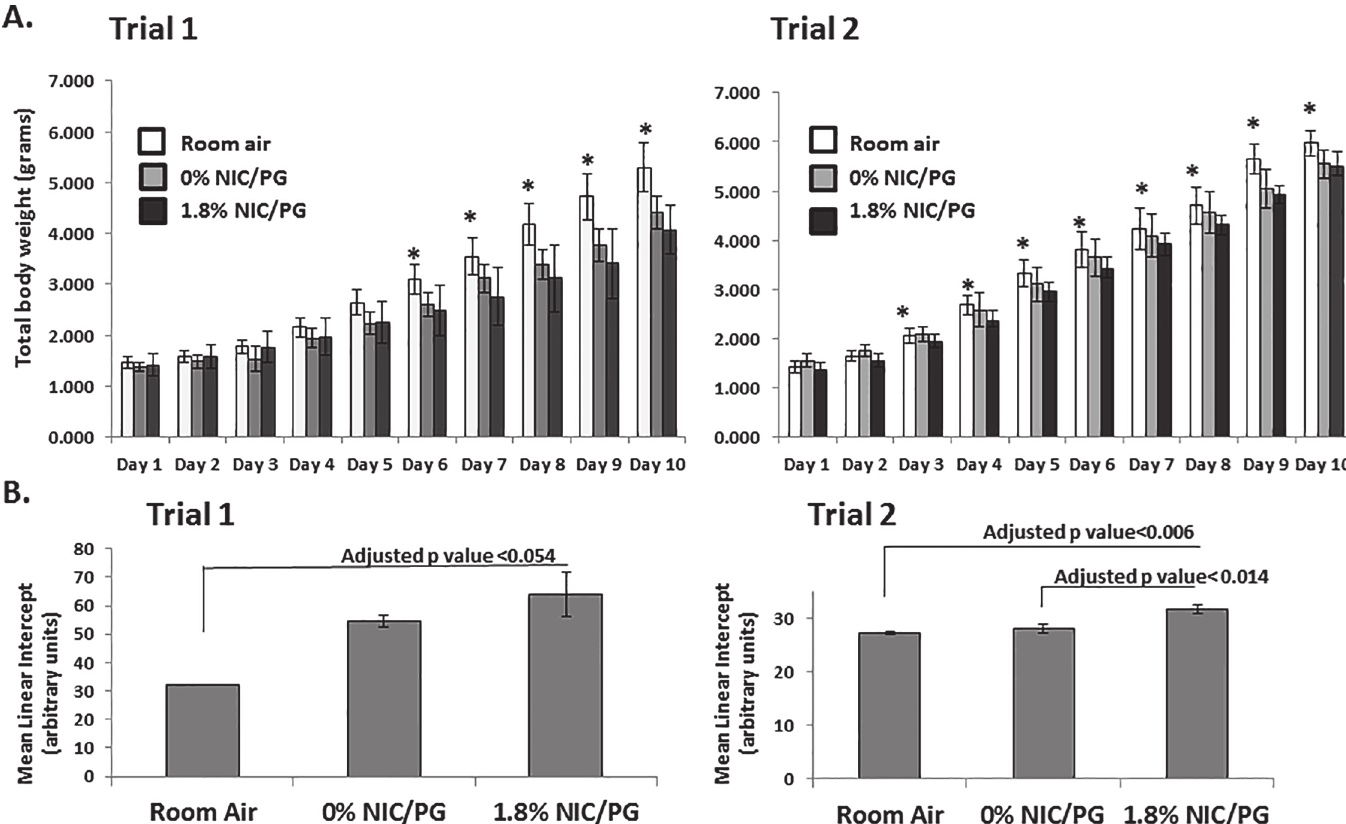
Fig 1. Effect of E-cigarette emissions on total body weight and mean linear intercept. A. Neonatal mice and their mothers were placed in a chamber and exposed to E-cigarette emissions starting at 24 hours of life. Age-matched control mice were kept in room air. Mice were exposed to either, 0% nicotine/ PG or 1.8% nicotine/PG, once a day (400 μ l cartridge) for the first two days of life, then twice a day for an additional 7 days. Room air mice in trial one and trial two were significantly heavier at days of life 6 and 3 respectively compared to age-matched 1.8% nicotine/PG exposed mice ( * p < 0.05) and remained significantly heavier up through 10 days of life. (n = 5 – 13 per group, error bars reflect standard deviation). B. Neonatal mice exposed to 1.8% nicotine/PG had a larger MLI, after adjusting for sex and weight compared to mice exposed to room air (Trial 1: p < 0.054 and Trial 2: p < 0.006). In trial 2 neonatal mice exposed to 1.8% nicotine/PG had significantly larger MLI than 0% nicotine/PG exposed mice ( p < 0.014). (n = 5 – 8 per group, error bars reflect standard error of the mean).